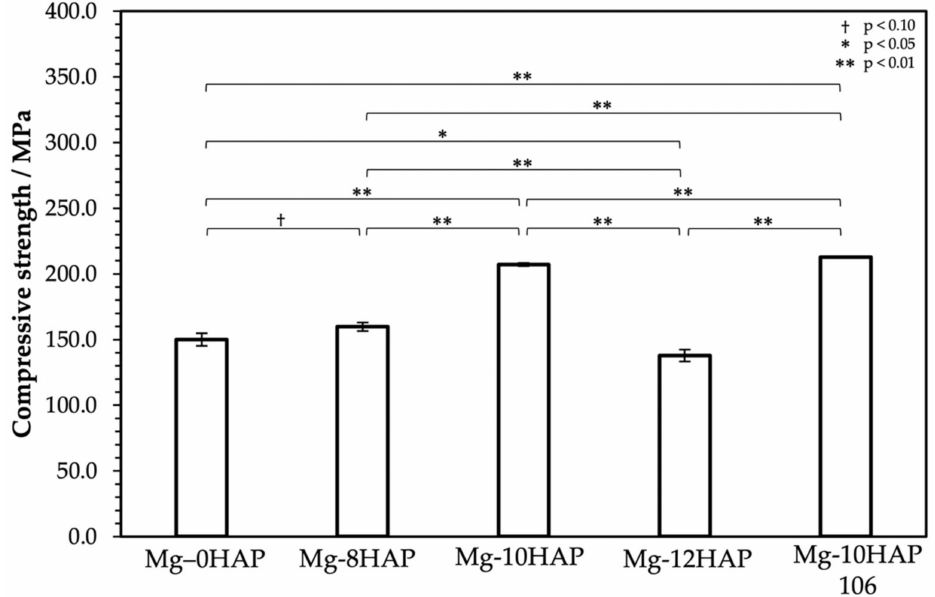
Figure 8. Compressive strength of the sintered composites after sintering using SPS system obtained from the compression